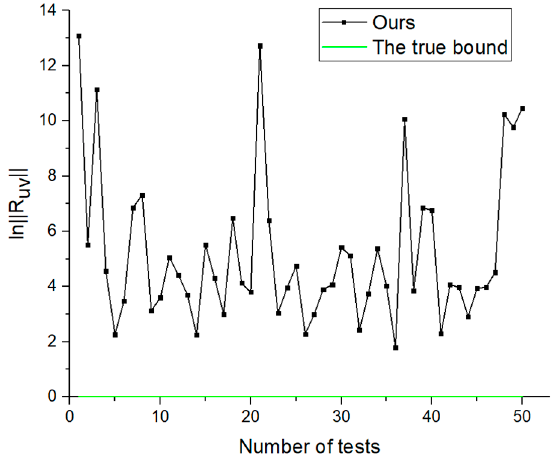
Figure 1. Comparison between bounds on the first-order derivative R u ( u ) of NURBS surfaces with fixed control points, fixed knot vectors and randomly selected weights.